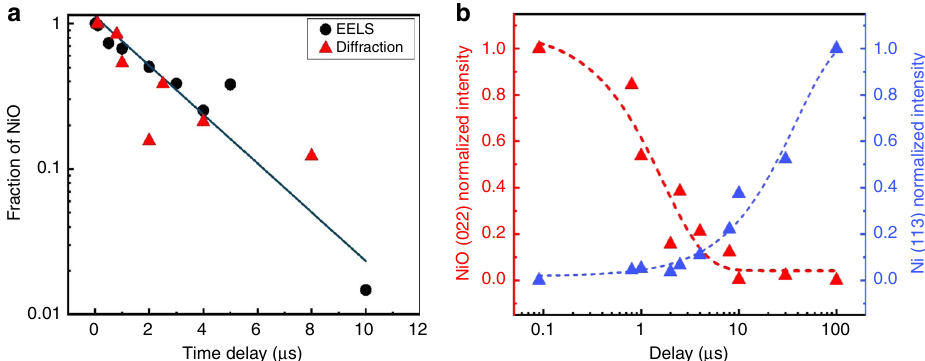
Fig. 6 Decomposition of NiO. a Temporal evolution of the fraction of non-reduced NiO as taken from EELS (black dots) and from the intensity of the (022) re fl ection of NiO (red triangles). There is a larger uncertainty in the quantitative analysis at low percentages of NiO. b Evolution of the diffraction intensities of the (022)-re fl ection of NiO and the (113)-re fl ection